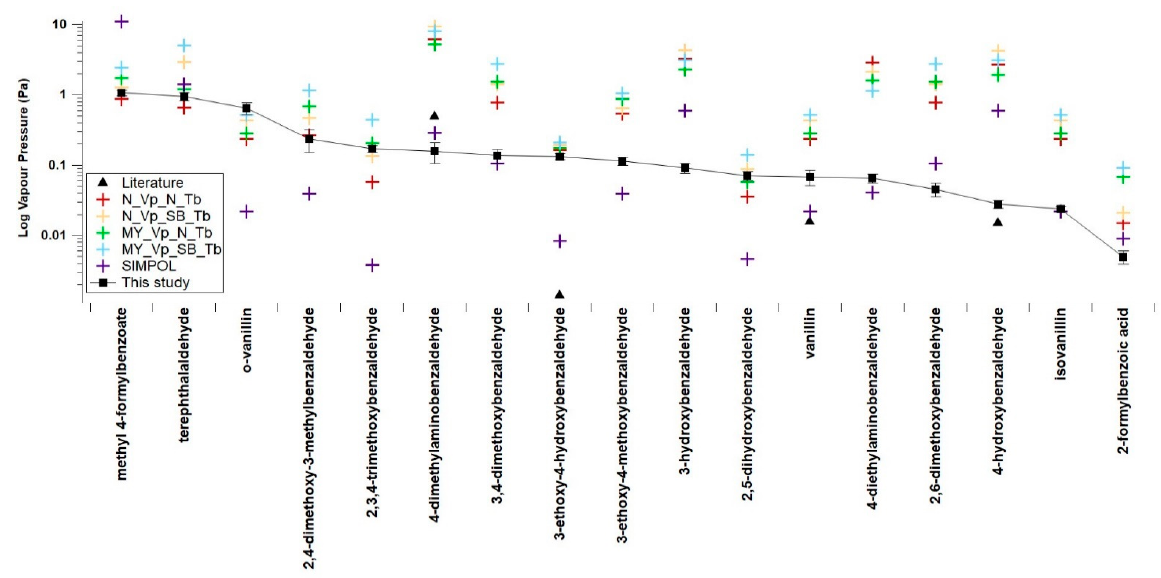
Figure 7. Comparison of estimated and measured sub-cooled saturation vapour pressures. N_Vp (Nanoolal vapour pressure), MY_Vp (Myrdal and Yalkowsky vapour pressure, SIMPOL (SIMPOL vapour pressure), N_Tb (Nannoolal boiling point), SB_Tb (Stein and Brown boiling point), Literature (4-dimethylaminobenzaldehyde from Daubert and Danner [46], 3-ethoxy-4-hydroxybenzaldehyde, vanillin, and 4-hydroxybenzaldehyde from Yaws [47]. Error bars are ± 1 standard deviation. Table 5. Table showing the average difference between the experimental (cid:1842) (cid:2896)(cid:2929)(cid:2911)(cid:2930) and the predicted (cid:1842) (cid:2896)(cid:2929)(cid:2911)(cid:2930) . N_VP is the Nan- noolal et al. method [6], MY_VP is the Myrdal and Yalkowsky method [7], N_Tb is the Nannoolal et al. method [36], SB_Tb is the Stein and Brown method [38].